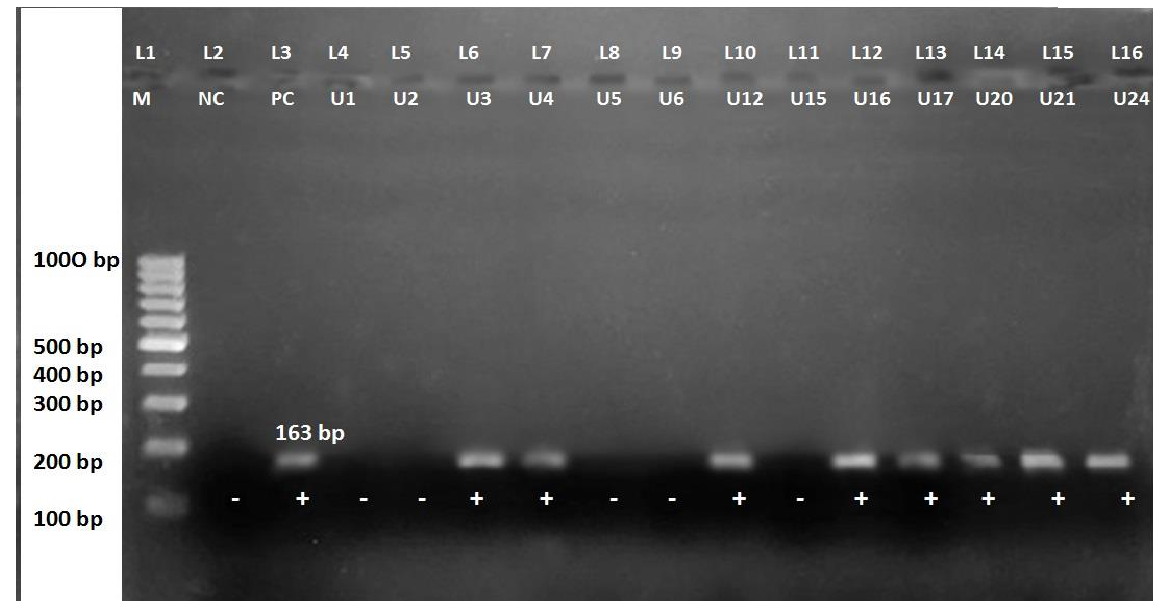
Figure 2. mec A gene amplified product after PCR in agarose gel electrophoresis. Lane 1:100 bp DNA ladder; lane 2: negative control; lane 3: positive control; lane 4: U1; lane 5: U2; lane 6: U3; lane 7: U4; lane 8: U5; lane 9: U6; lane 10: U12; lane 11: U15; lane 12: U16; lane 13: U17; lane 14: U20; lane 15: U21; lane 16: U24.